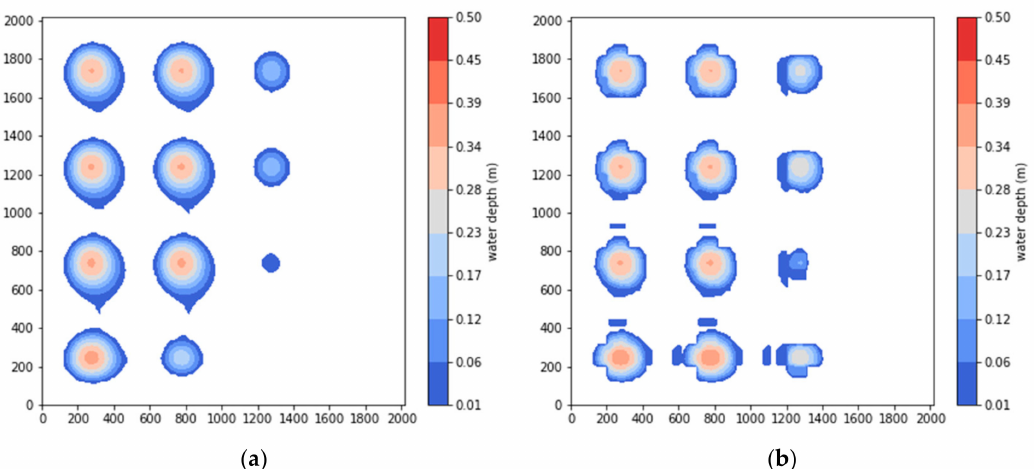
Figure 7. EAT2: predicted water depth at 48 h by ( a ) the CA-4D model with 20 m resolution and ( b ) the HIM.